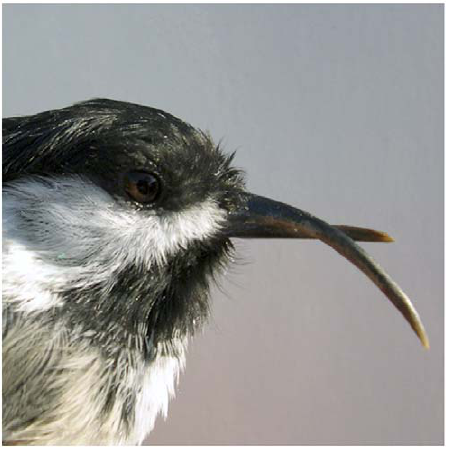
Figure 1. Black-capped chickadee affected by avian keratin disorder. An individual from an Alaskan population of black-capped chickadees shows Avian keratin disorder. The disease produces elongated and crossed beak phenotypes.